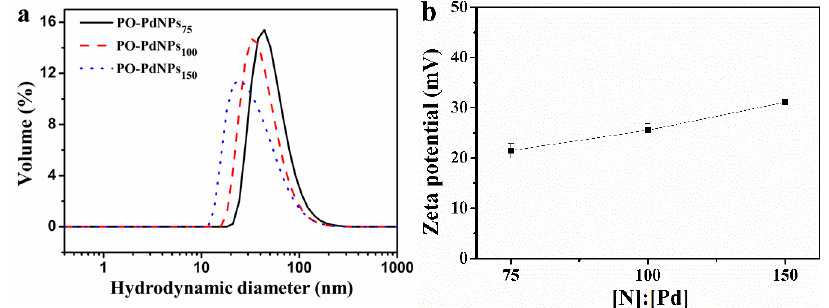
Figure 4. ( a ) Hydrodynamic diameter and ( b ) zeta potential of PO-PdNPs n .